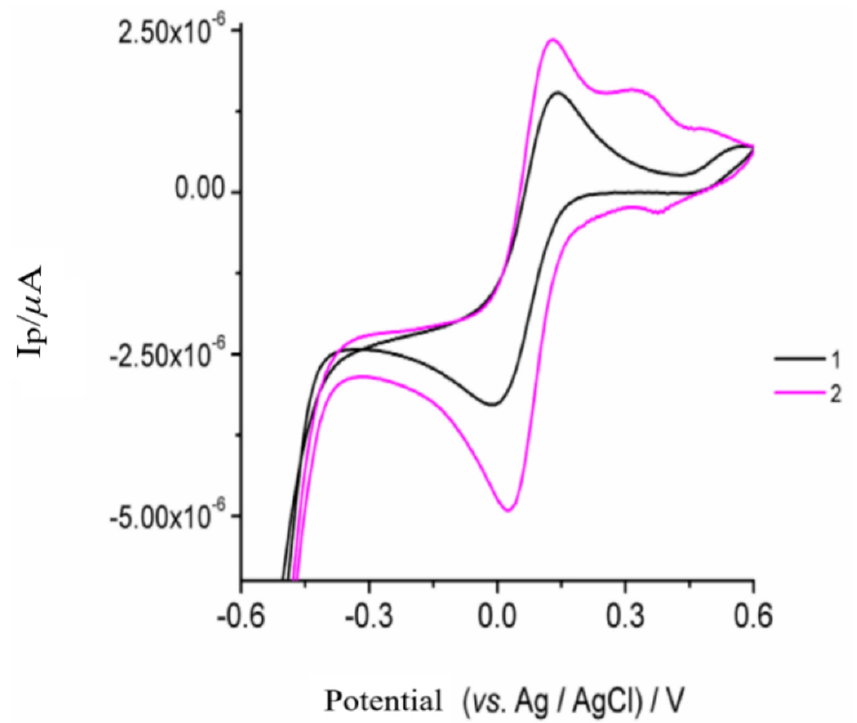
Figure 3. Cyclic voltammograms of 1 × 10 − 3 mol L-1 K3[Fe (CN)6] in 0.2 mol L-1 KCl on the (1) CPE and (2) poly-AgNPs@Sa-CPE, respectively. The conditions are described in the material and methods section.